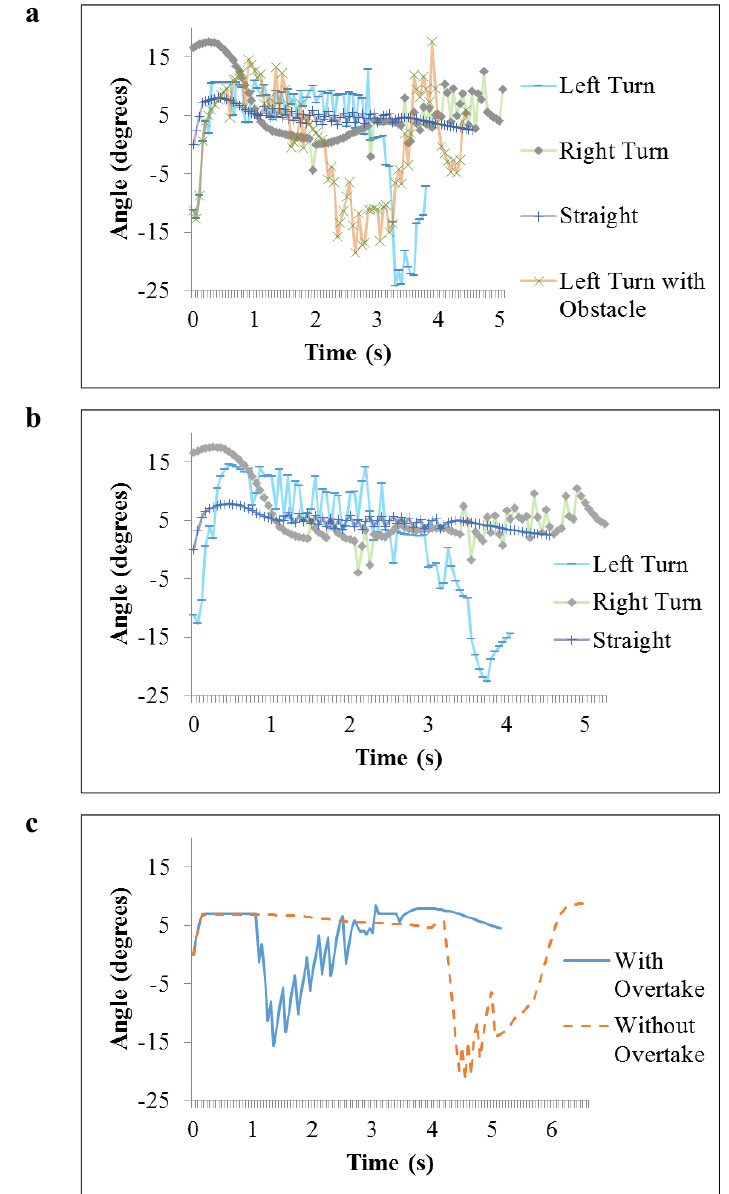
Figure 15. Angle difference between orientation of road and vehicle vs . time for: ( a ) scenarios with one vehicle; ( b ) scenarios with two vehicles; ( c ) overtaking